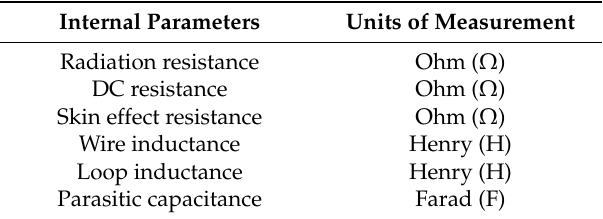
Table 3. The internal parameters that are present in the LC